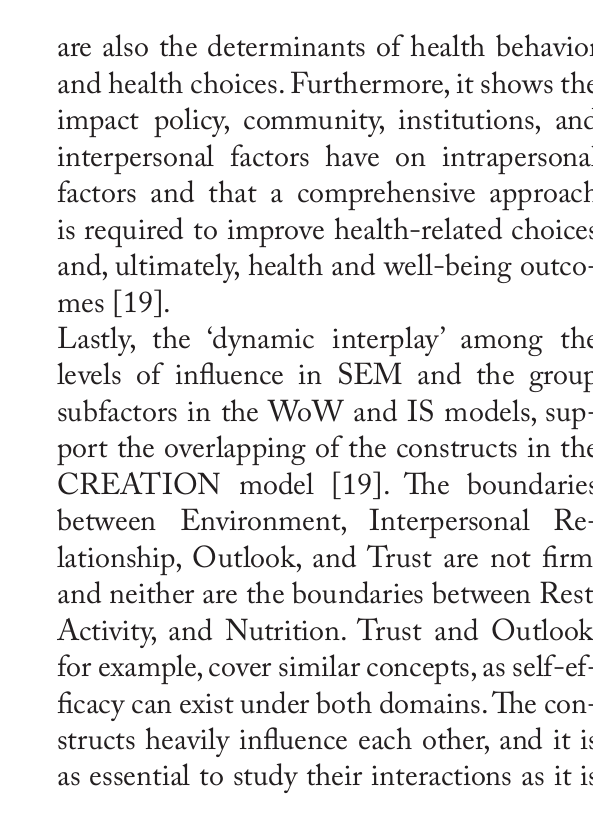
Figure 3. How behavior change theories Reasoned action approach (RAA), Social-Ecological Model (SEM) and Transtheoretical Model (TTM) influence the CREATION